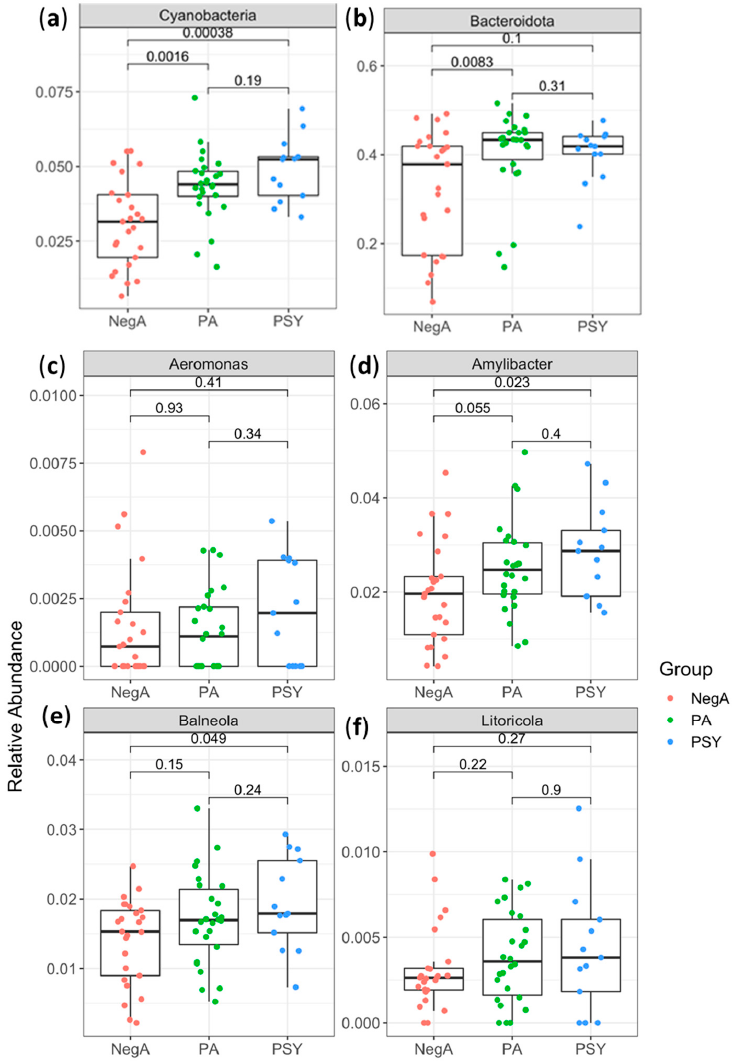
Figure 2. Change in composition of the nasal microbiota at the phylum in COVID-19 positive asymptomatic (PA) and COVID-19 positive symptomatic (PSA) patients compared to negative patients (NegA). The ( a ) Cyanobacteria show significantly high abundance in PA and PSA compared to NegA, and ( b ) Bacteroidota, ( c ) Aeromonas, ( d ) Amylibacter, ( e ) Balneola, and ( f ) Litaricola showed a trend of higher abundance. Within each box, horizontal black lines denote median values; boxes extend from the 25th to the 75th percentile of each group’s distribution of values; vertical extending lines denote adjacent values (i.e., the most extreme values within 1.5 interquartile range of the 25th and 75th percentile of each group); dots denote observations outside the range of adjacent values; and p -values were calculated using multiple-group Kruskal–Wallis test and two-group Wilcoxon